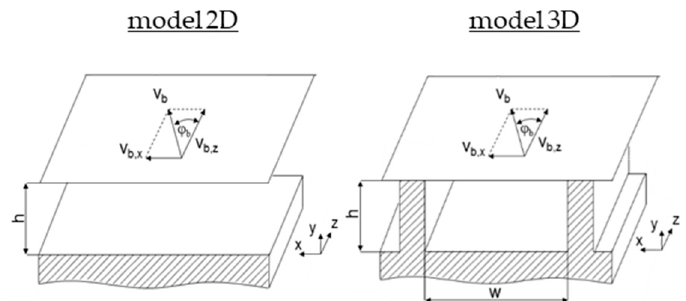
Figure 5. Representation of the screw channels in the two- and three-dimensional melt-conveying models. Ignoring the curvature of the screw, the flat-plate model with moving barrel was applied in both cases.